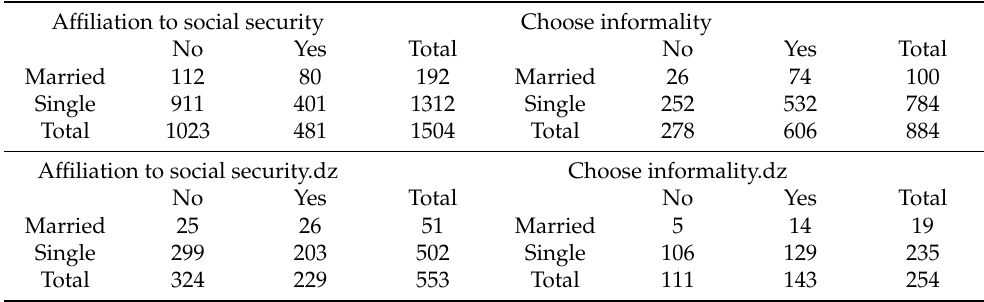
Table A2. Affiliation to social security and the reason for not being insured according to marital status. Source: Sahwa